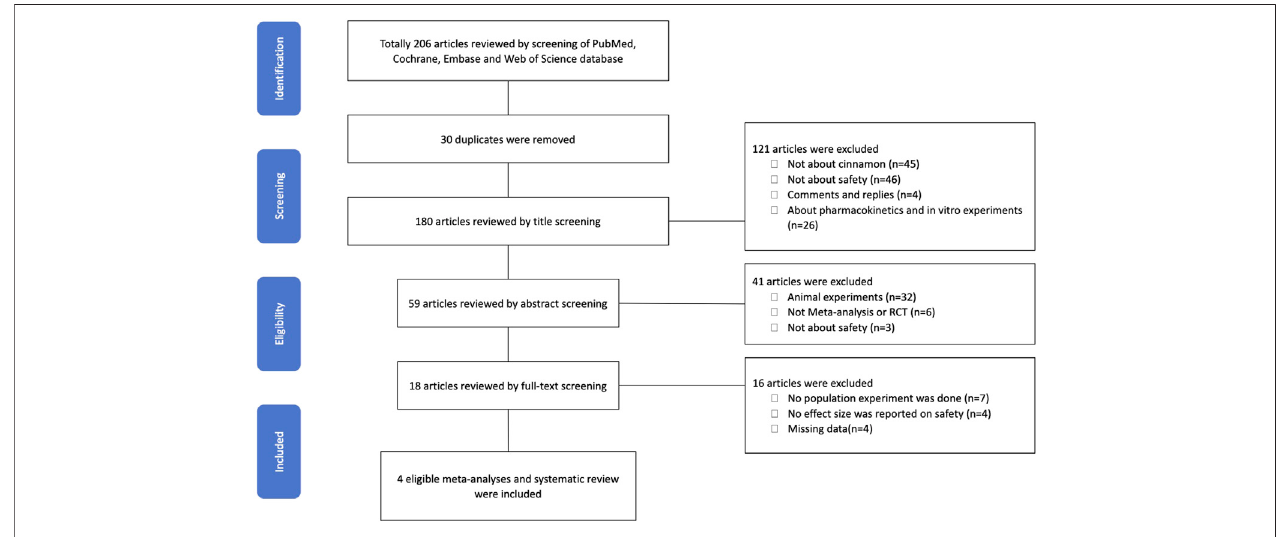
FIGURE 1 | PRISMA fl ow diagram of the